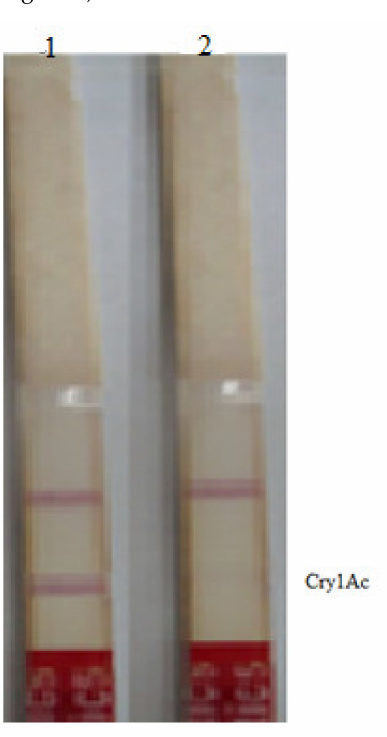
Figure 2. Immunoassay results of transient expression of the Cry1Ac gene in N.tabacum leaves tran- siently transformed with theCry1Ac constructs. Lane 1 contains extracts of cotton plants infiltrated with the construct driven by the CLCuKoV-BuC1 promoter in which CryAc protein was detected. Lane 2 contains extracts of cotton plants infiltrated with CLCuKoV-BuC1 minus the bidirectional promoter, in which no CryAc protein was